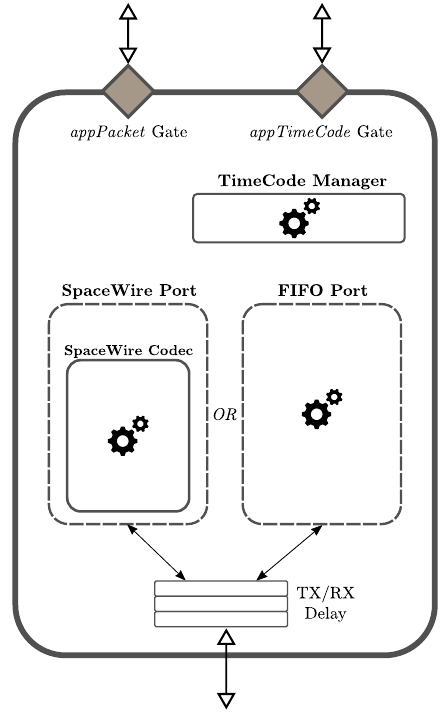
Figure 3. Internal architecture of a SpaceWire